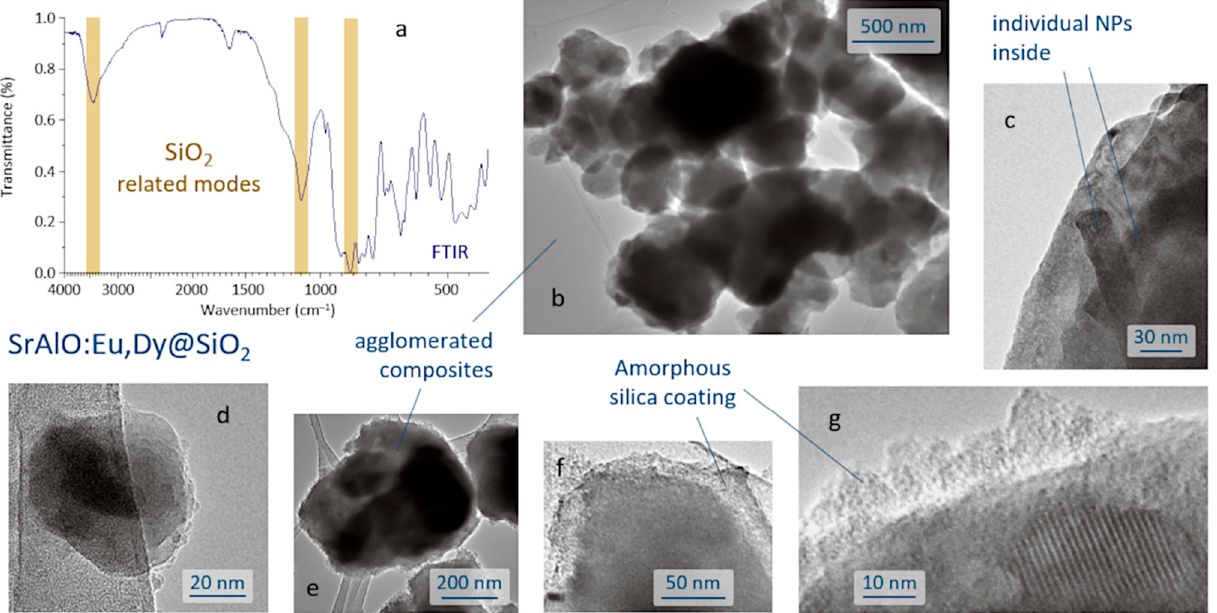
Figure 3. Production of SrAlO:Eu,Dy@SiO 2 composites by a reverse micelle protocol. ( a ) FT-IR spectrum of the sample obtained after the coating process. ( b – g ) TEM images of the composites showing different details of the core-shell structure.